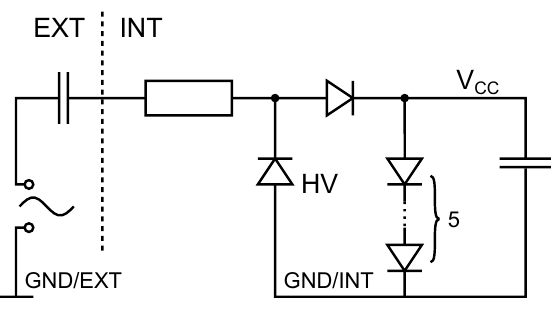
Figure 6. Schematic of the Voltage Supply.